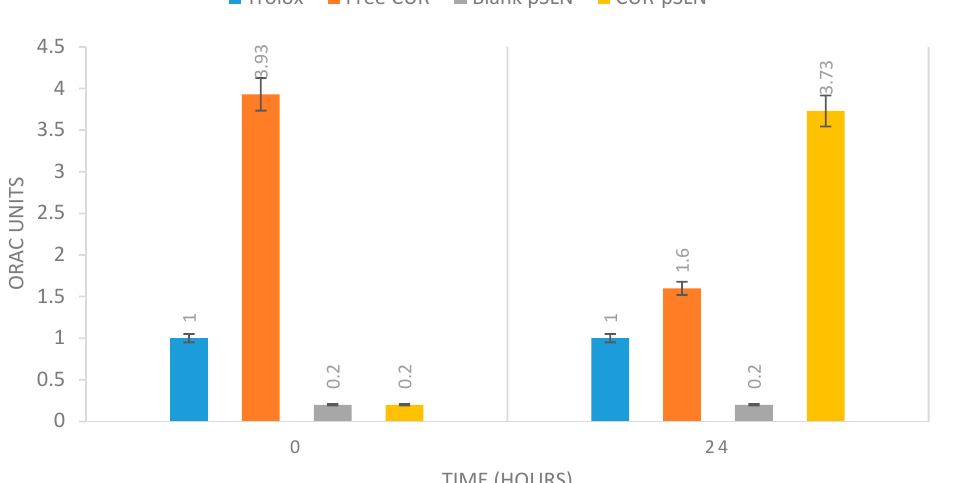
Figure 10. Oxygen Radical Absorbance Capacity (ORAC) activity of Trolox, curcumin, blank pSLNs and CUR-pSLNs. Trolox = 1 Units ORAC.